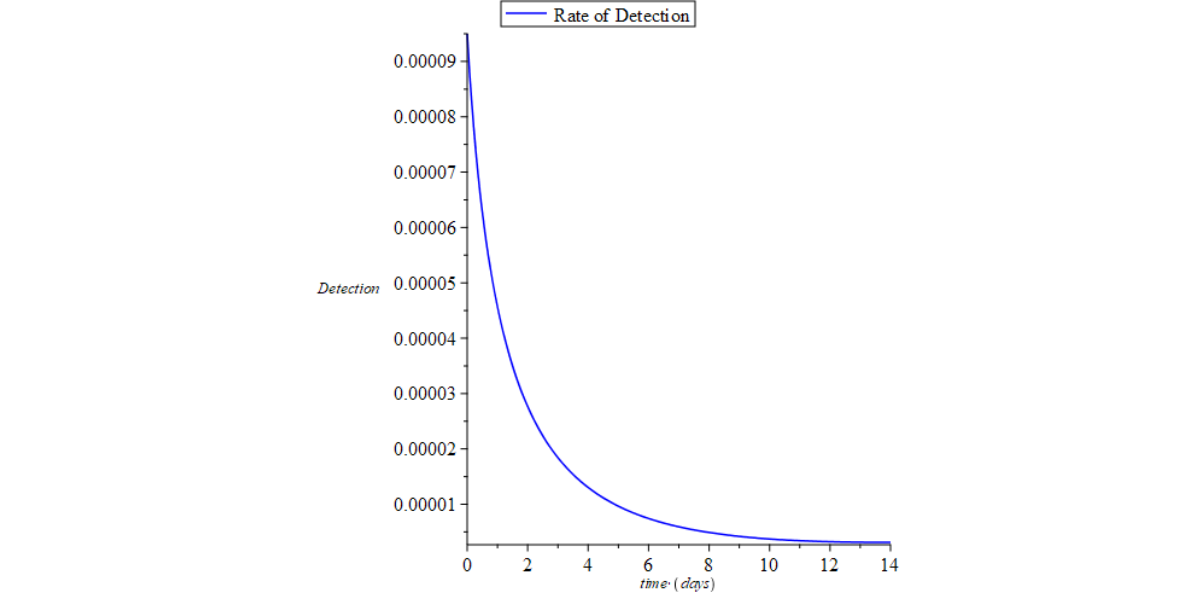
Figure 4. Chart of the rate of reinfection of the recovered compartment from coronavirus